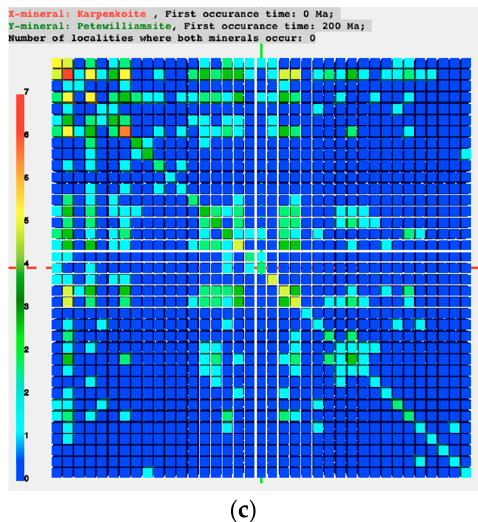
Figure 5. Visualization outputs showing co-relations between primary and secondary cobalt minerals. Minerals are arranged by their first occurrence time (old to young: left to right along the horizontal X-axis; top to bottom along the vertical Y-axis). The raw value in each cell represents the number of localities at which both the X and Y minerals occur. ( a ) Primary to primary (raw values); ( b ) primary (Y) to secondary (X), with logarithmic values; and ( c ) secondary to secondary, with logarithmic values.